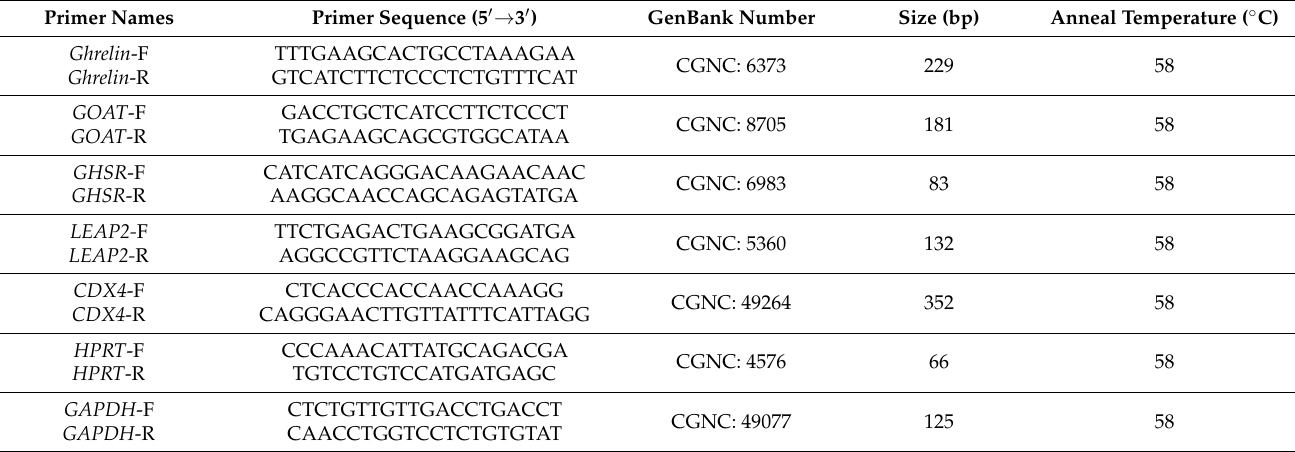
Table 1. Parameters of primers used for real time quantitative polymerase chain